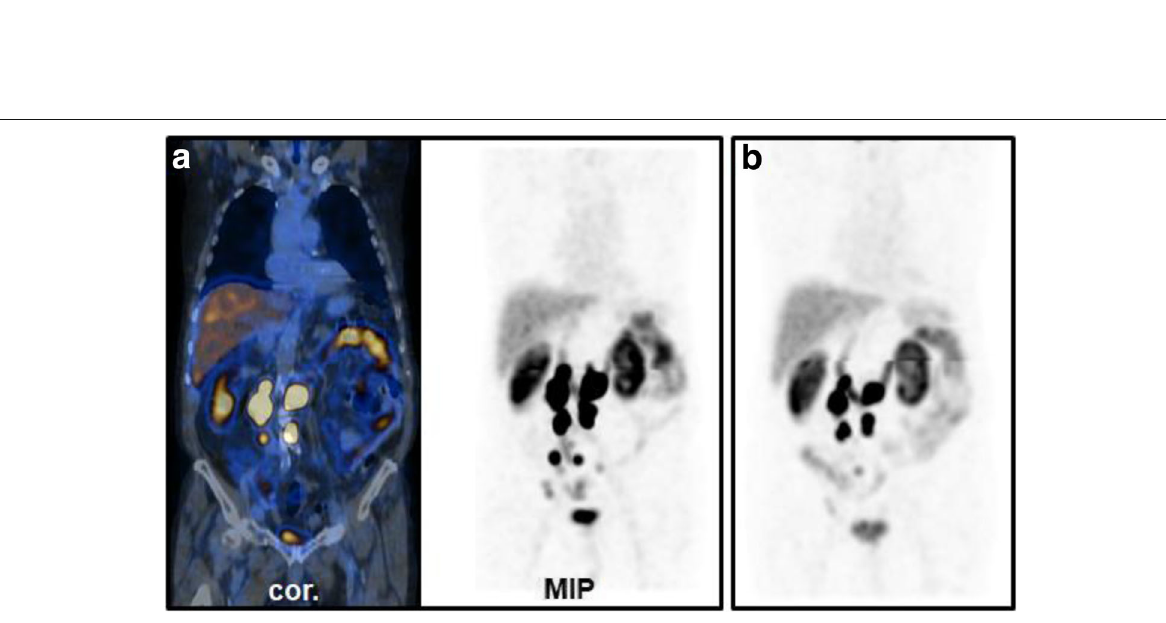
Fig. 5 [ 99m Tc]Tc-PSMA-I&S-SPECT/CT of an 82-year-old patient with mCRPC and disease progression under chemotherapy (docetaxel). a Pretherapeutic tumor spread (PSA 137 ng/ml). b Restaging 3 months after the second cycle of 177 Lu-PSMA therapy (PSA 60